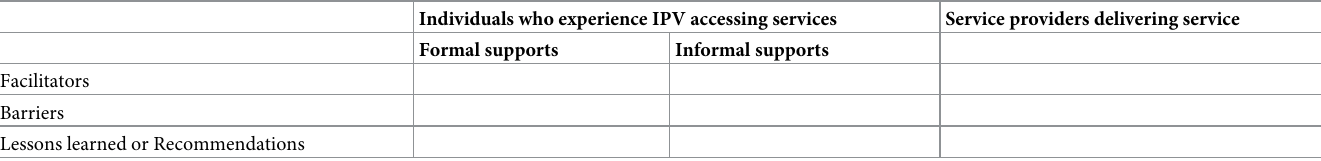
Table 4. Example tabular presentation of data for the scoping